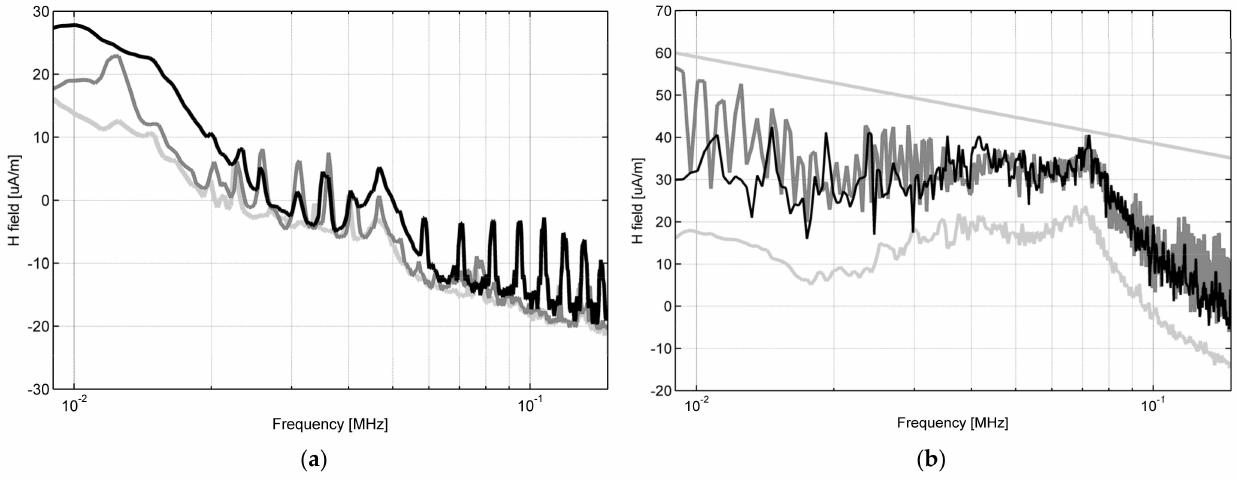
Figure 8. Line resonance and interaction with rolling stock (same test track and location with two different locomo- tives): ( a ) no vehicle in the measurement area (light gray), auxiliaries on with pantograph down (gray) and up (black); ( b ) background (light grey), braking (dark gray). and acceleration (black). Shift of line resonance from ( a ) 47 kHz to ( b ) 72